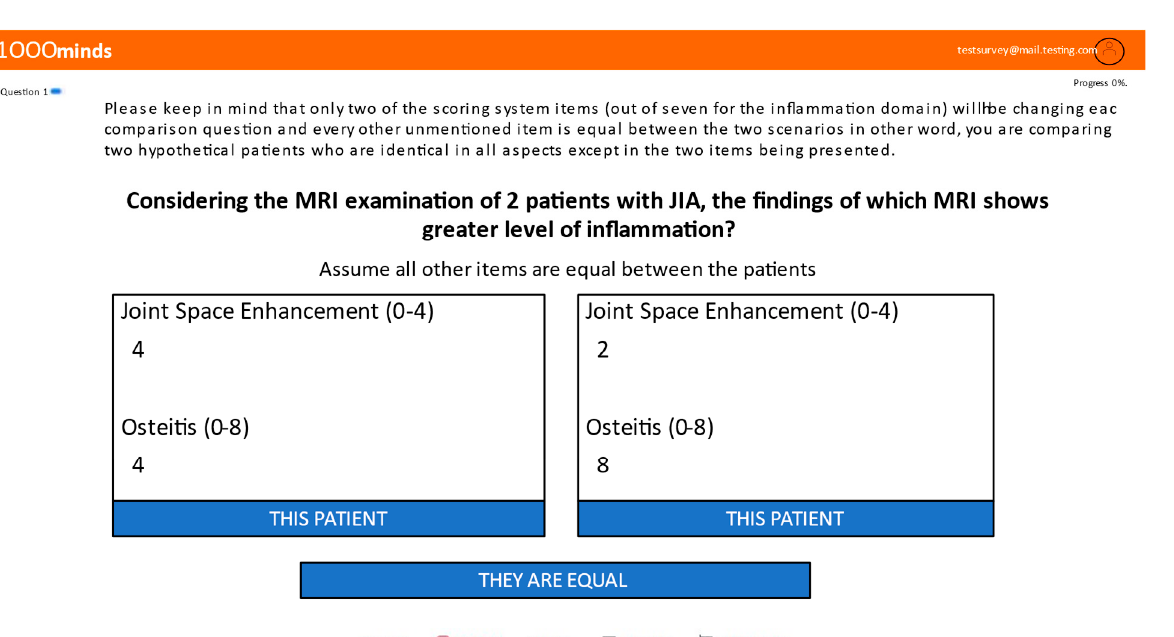
Figure A2. JAMRIS-SIJ damage domain item comparison. An example of an item comparison ques- tion presented by the 1000Minds software to the rating experts to elicit their preferences on the relative importance weights for the JAMRIS-SIJ damage domain items. The expert was asked to